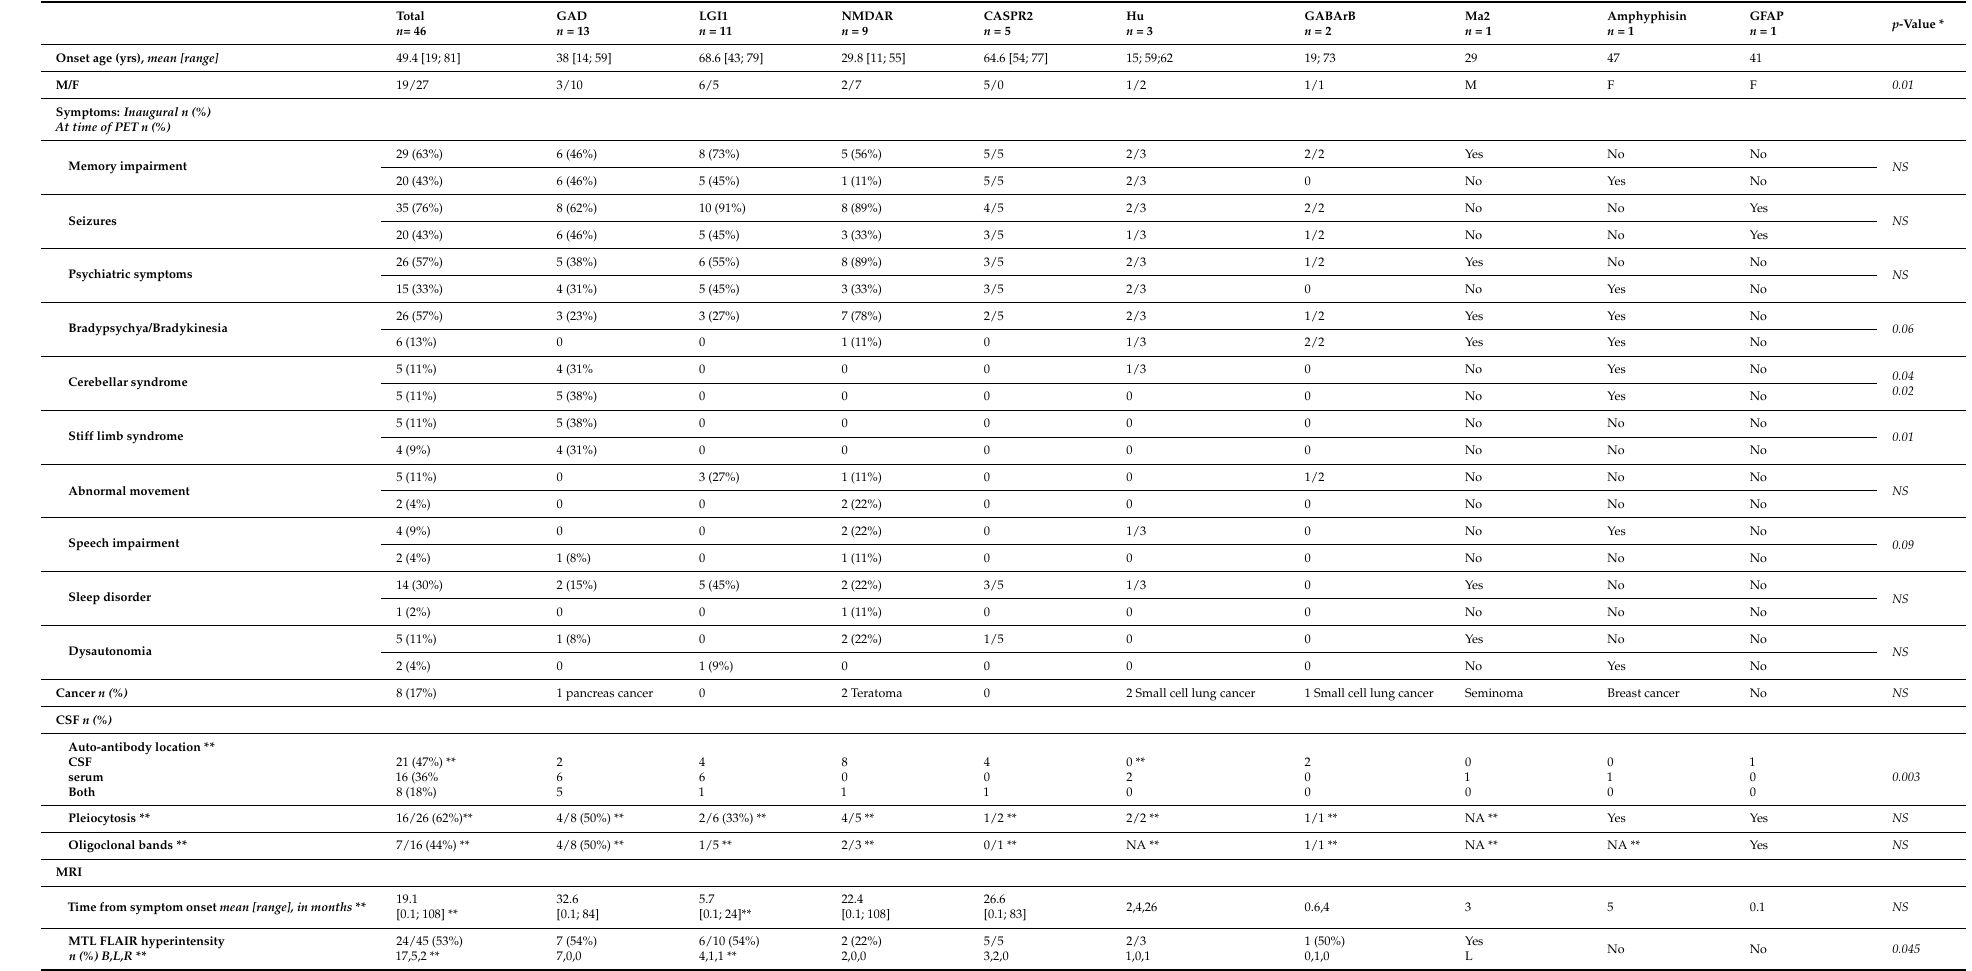
Table 1. Demographic, clinical, CSF, and MRI finding across autoantibody